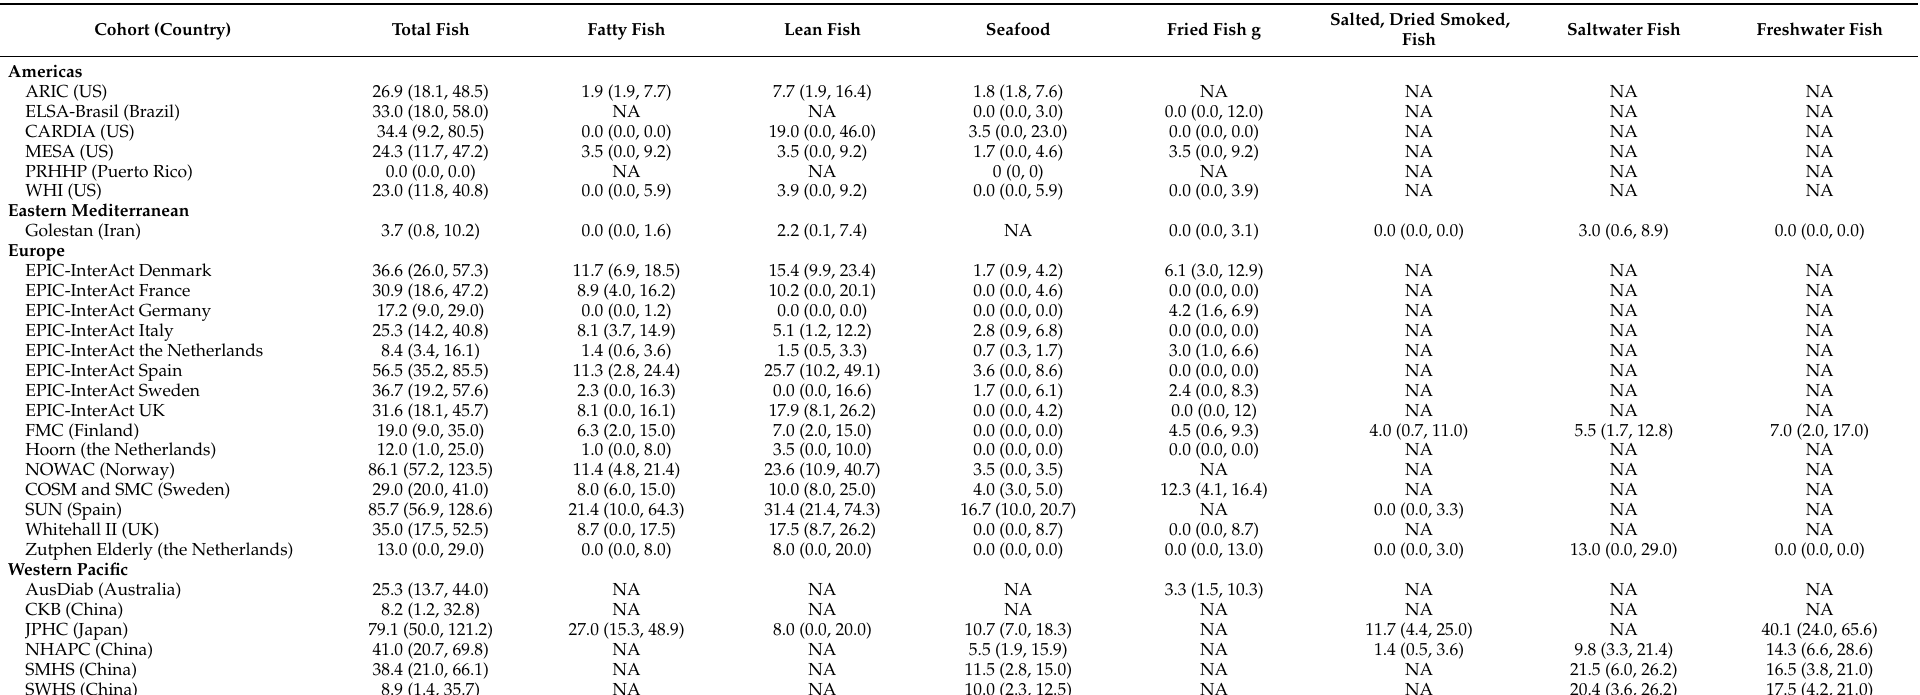
Table 2. The consumption of total and types of fish in the InterConnect Project by region and cohort. Cohort (Country) Lean